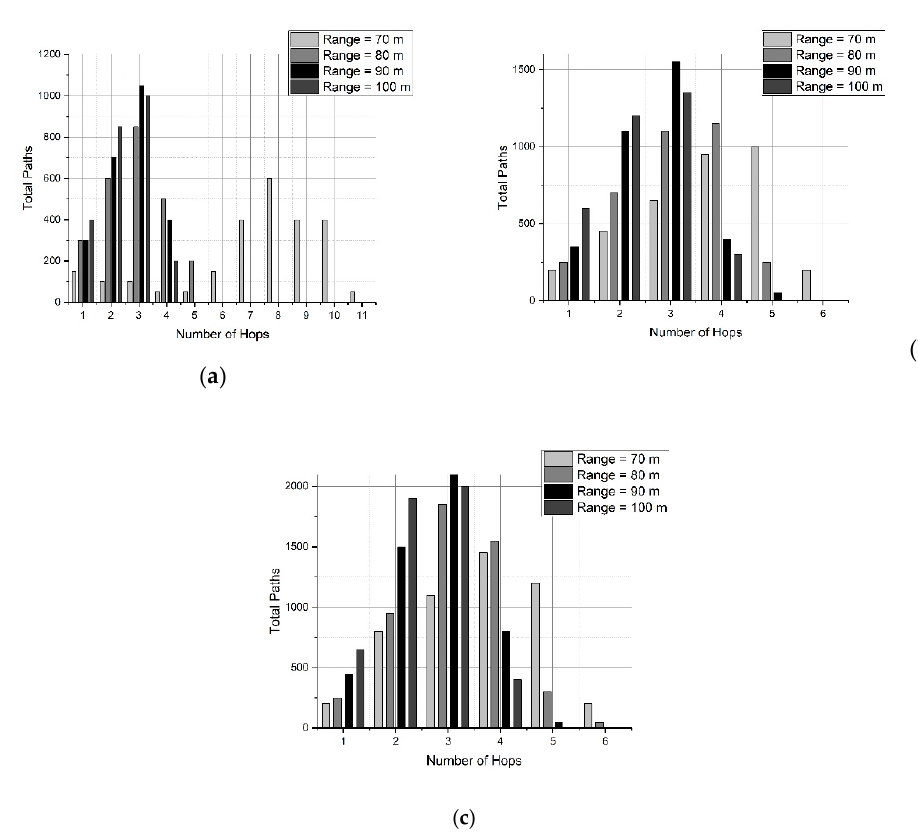
Figure 9. Number of paths for different network sizes (nodes): ( a ) 50, ( b ) 70 and ( c ) 100.